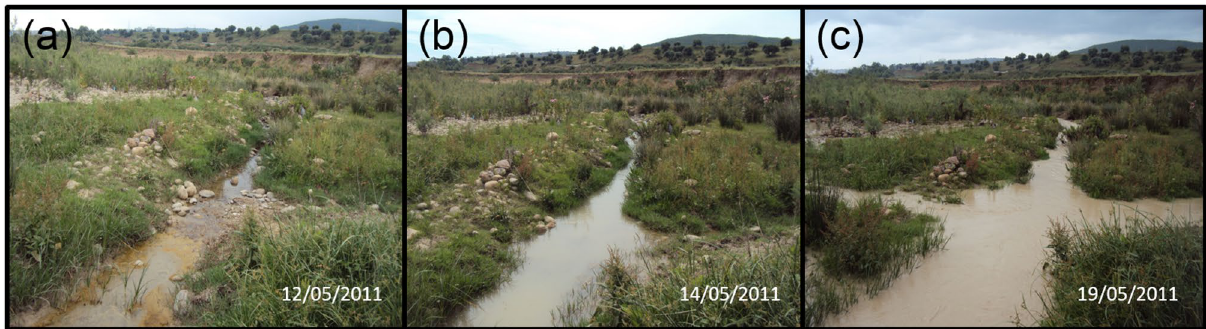
Figure 5. Variability of stream water level where the endangered Calopteryx exul reproduced, Seybouse River, northeastern Algeria. ( a ) stream nearly dry, ( b ) intermediate water level (preferred level of the damselfly), and